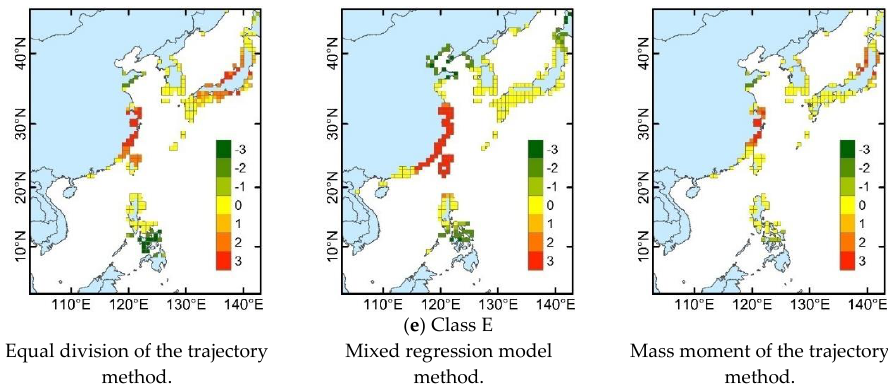
Figure 5. ( a – e ) Spatial distribution of landfall locations for the TCs in different classes according to the different trajectory clustering methods. Red indicates the frequent landfall locations, and green indicates the infrequent landfall locations. A value of ± 3 is statistically significant at a confidence level of 99%, ± 2 is statistically significant at a confidence level of 95%, and ± 1 is statistically significant at a confidence level of 90%; 0 indicates that the results are not significant.